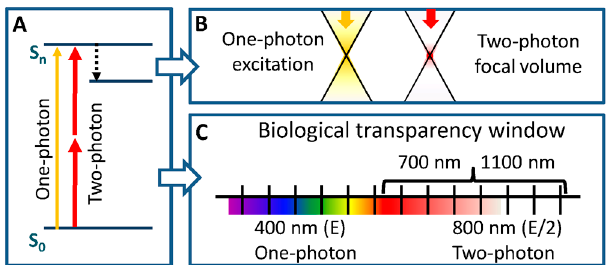
Figure 5. Principle of two-photon absorption. ( A ) Simultaneous two-photon absorption; ( B ) Comparison of excitation volume in one- versus two-photon absorption; ( C ) Two-photon absorption allows shifting the excitation of UV–visible fluorophores in the near-infrared region within the biological transparency window. The energy of each photon in two-photon absorption is halved (E/2) in comparison with that in classical absorption (E).